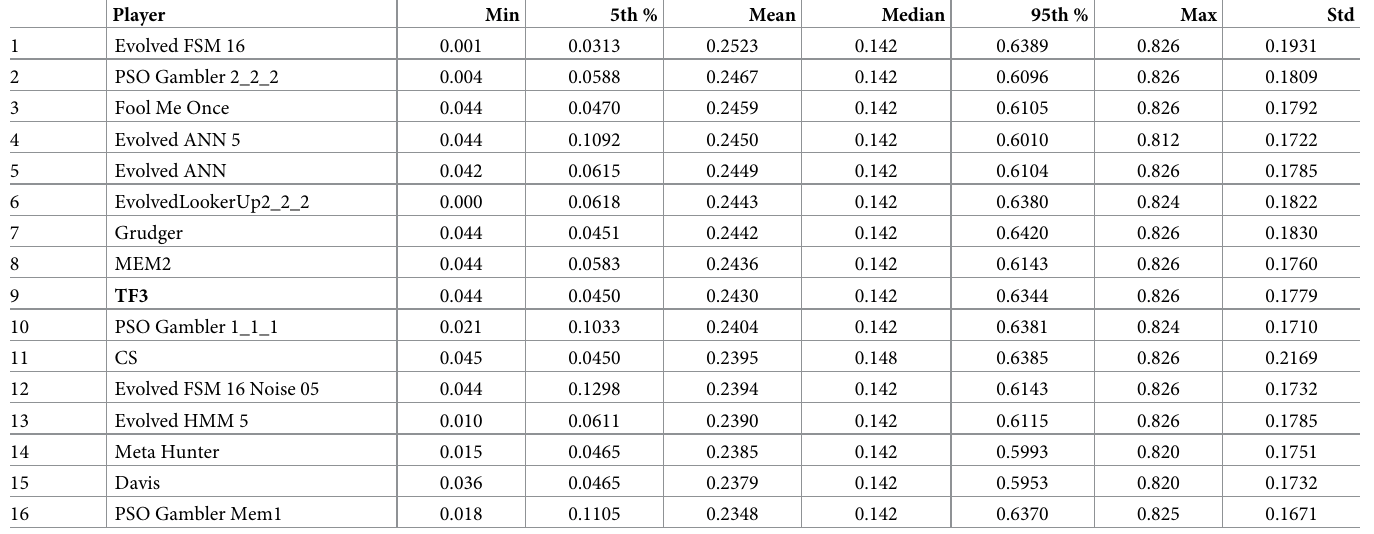
Table 6. Top invaders for N =